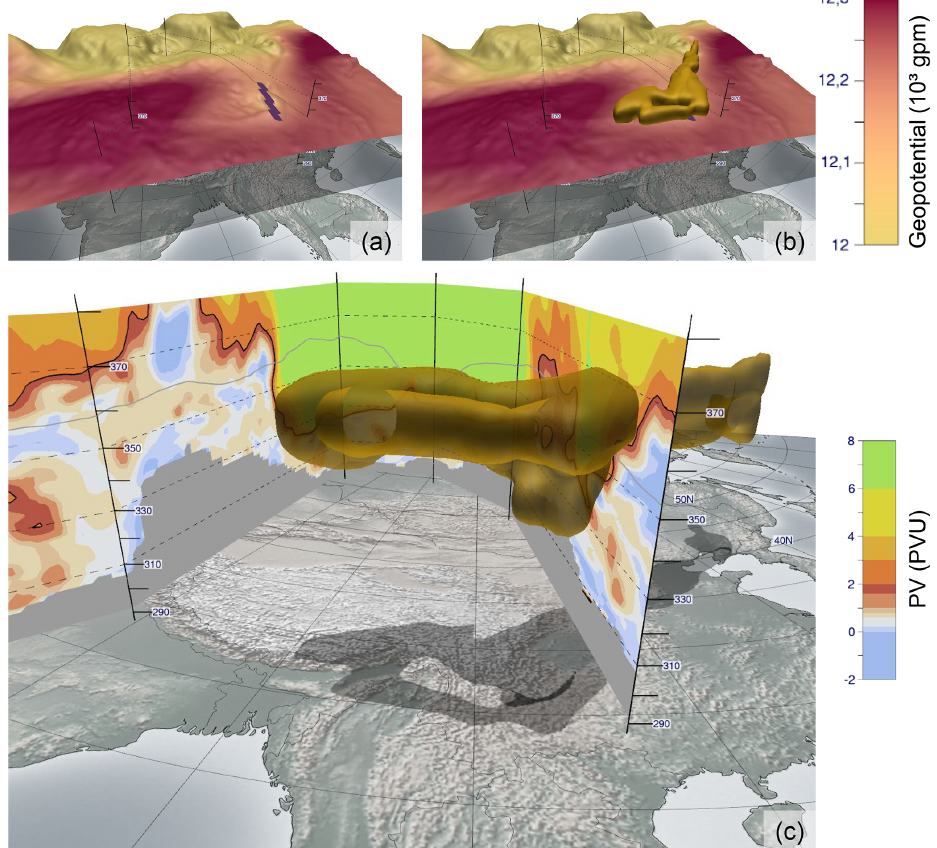
Figure 12. Comparison of the location of the anomalies defined by the 200hPa geopotential height and by the dynamical tropopause, on 25 July 2015, 12:00 UTC. (a) Shown is the 200hPa isosurface on isentropic levels, shaded by geopotential height. The purple line is the trough identified by van der Linden et al. (2017) in a 2-D environment, cf. their Fig. 7. (b) Same as (a) , but the identified PVA has been added. Its location clearly coincides with the geopotential trough and the identified trough axis. (c) A vertical cross-section of the area along the section indicated in (a,b) and the identified PVA. Shaded on the cross-section is the PV, where the black contour highlights the 2PVU boundary. The gray line is the 200hPa contour and thus a cut of panel (a)